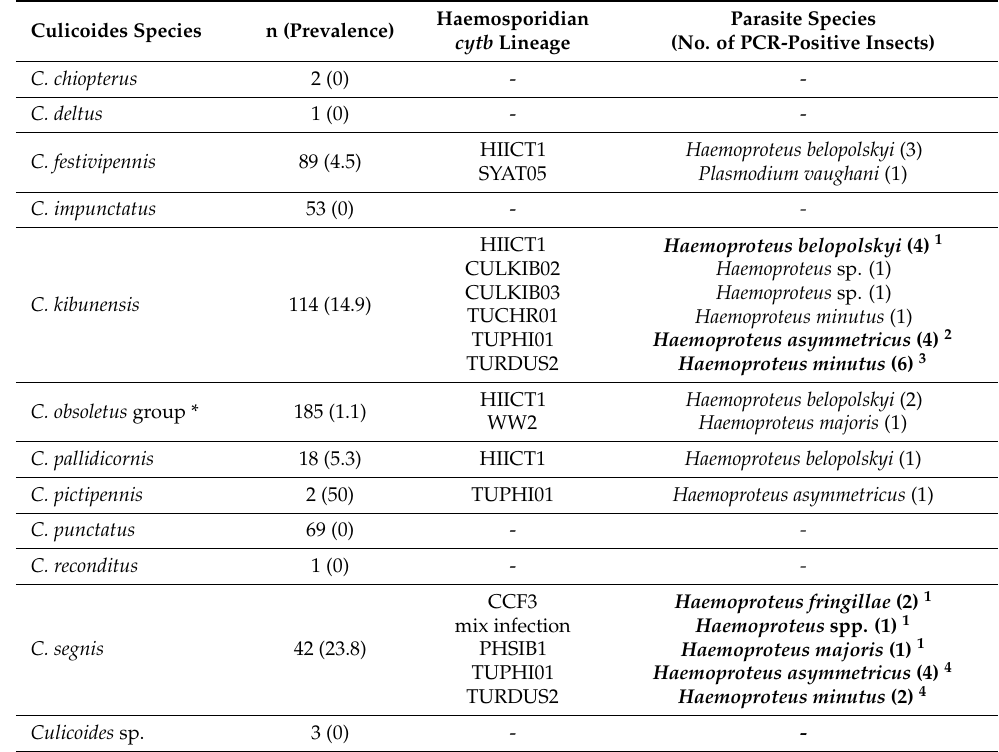
Table 1. Summary of collected Culicoides biting midges, with their respective Haemoproteus species and lineages.